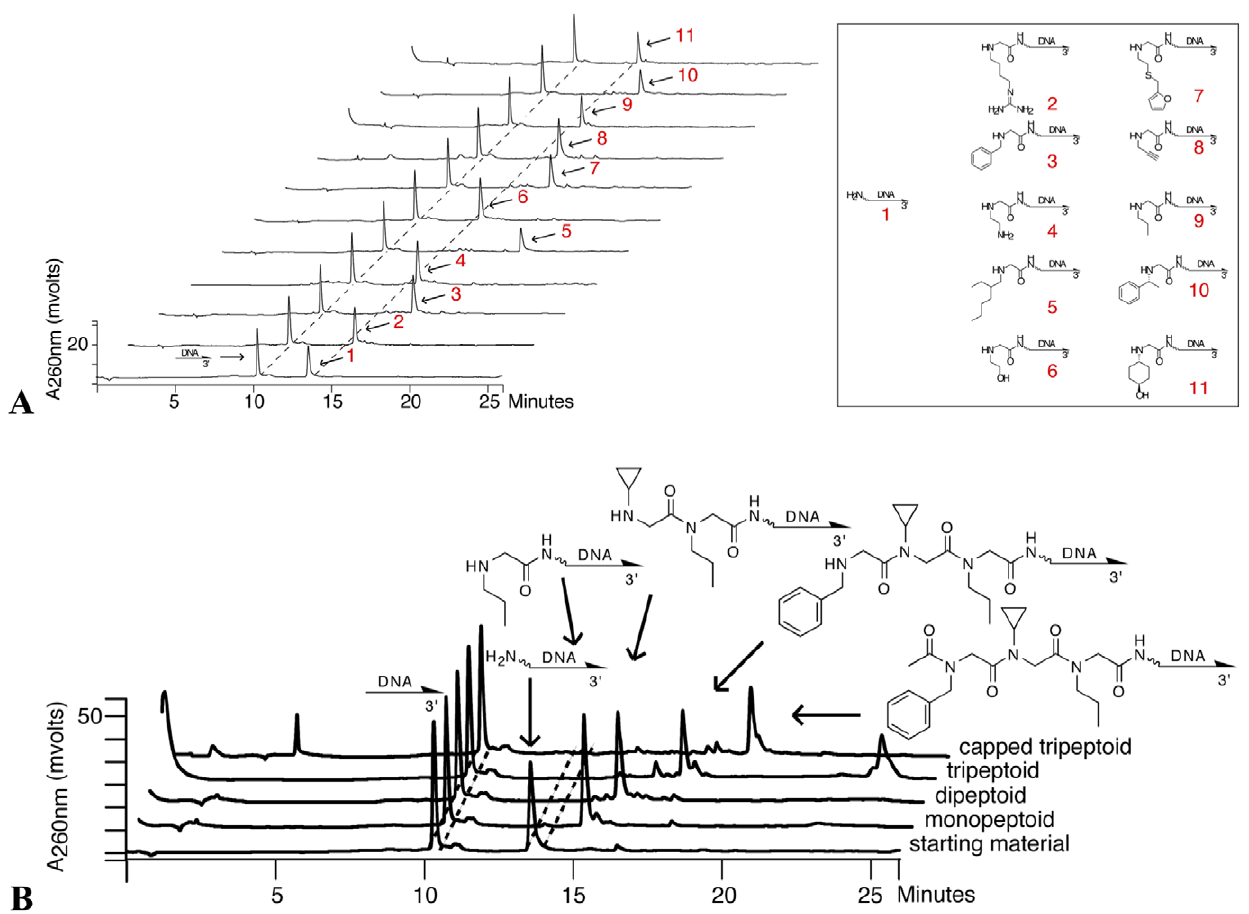
Figure 4. Parallel peptoid synthesis reactions on anion-exchange arrays. ( A ) A control 10-mer and a 5 9 aminated 20-mer oligonucleotide were loaded in adjacent wells of a gasketed Q cellulose chemistry array and subjected to a chloroacetylation step followed by an alkylation step with one of 10 primary amines. After elution, the products were analyzed by reverse-phase HPLC. The peaks corresponding to the peptoid products were isolated, digested with P1 nuclease, and analyzed by LC-MS to confirm the identity of the product. The masses obtained by LC-MS are listed in the supporting materials (Table S1). ( B ) A control 10-mer and a 20-mer oligonucleotide with a 5 9 primary amine were loaded in adjacent wells of a gasketed Q cellulose chemistry array (starting material) and subjected to one (monopeptoid), two (dipeptoid), or three (tripeptoid) peptoid coupling steps. Additionally, a synthesis consisting of three peptoid coupling steps and a subsequent acetylation step (capped tripeptoid) was performed. After elution, the products were analyzed by reverse-phase HPLC. The peak for the capped tripeptoid synthesis was isolated, digested with nuclease P1, and submitted for analysis by LC-MS. The identity of the major peak (approximately 88% yield) was confirmed ([M-H] 2 observed, 898.99; expected, 898.47).